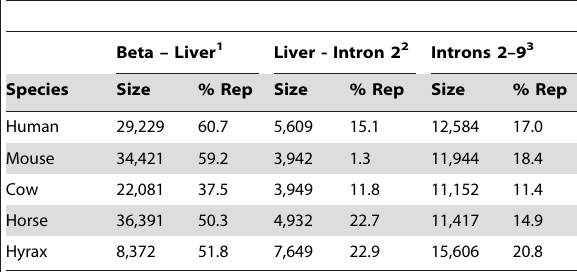
Table 2. Repetitive DNA content of introns within mammalian glucokinase